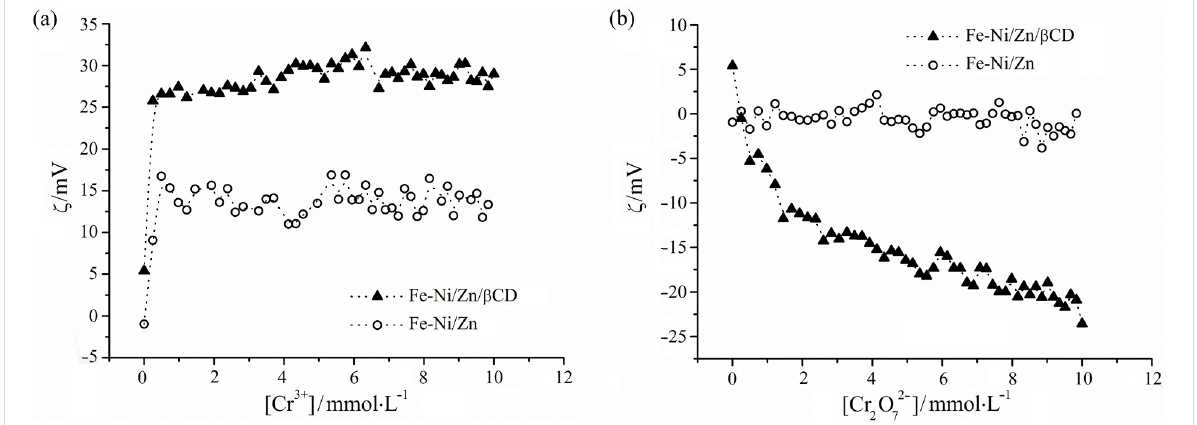
Figure 8: Adsorption curves of (a) Cr 3+ and (b) Cr 2 O 72 − ions using Fe-Ni/Zn and Fe-Ni/Zn/ β CD aqueous suspensions.